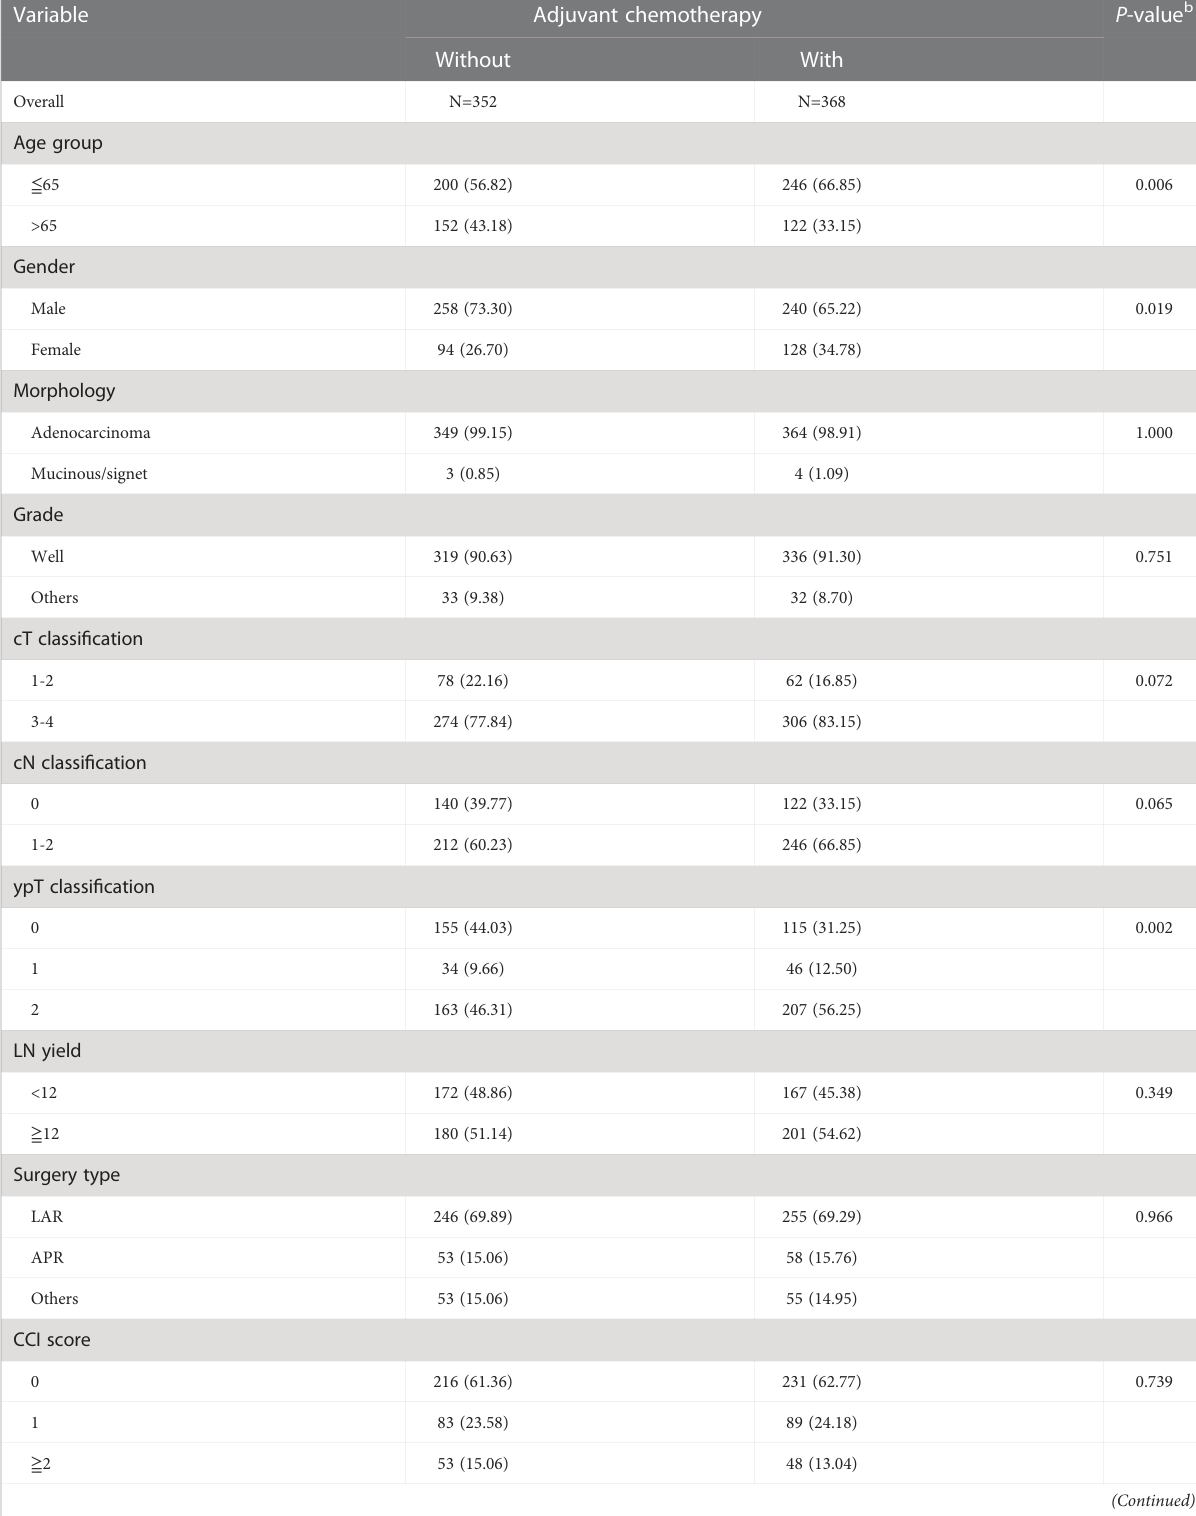
TABLE 1 Clinicopathological information of rectal cancer patients with good response (ypT0-2N0) after nCRT and surgery,